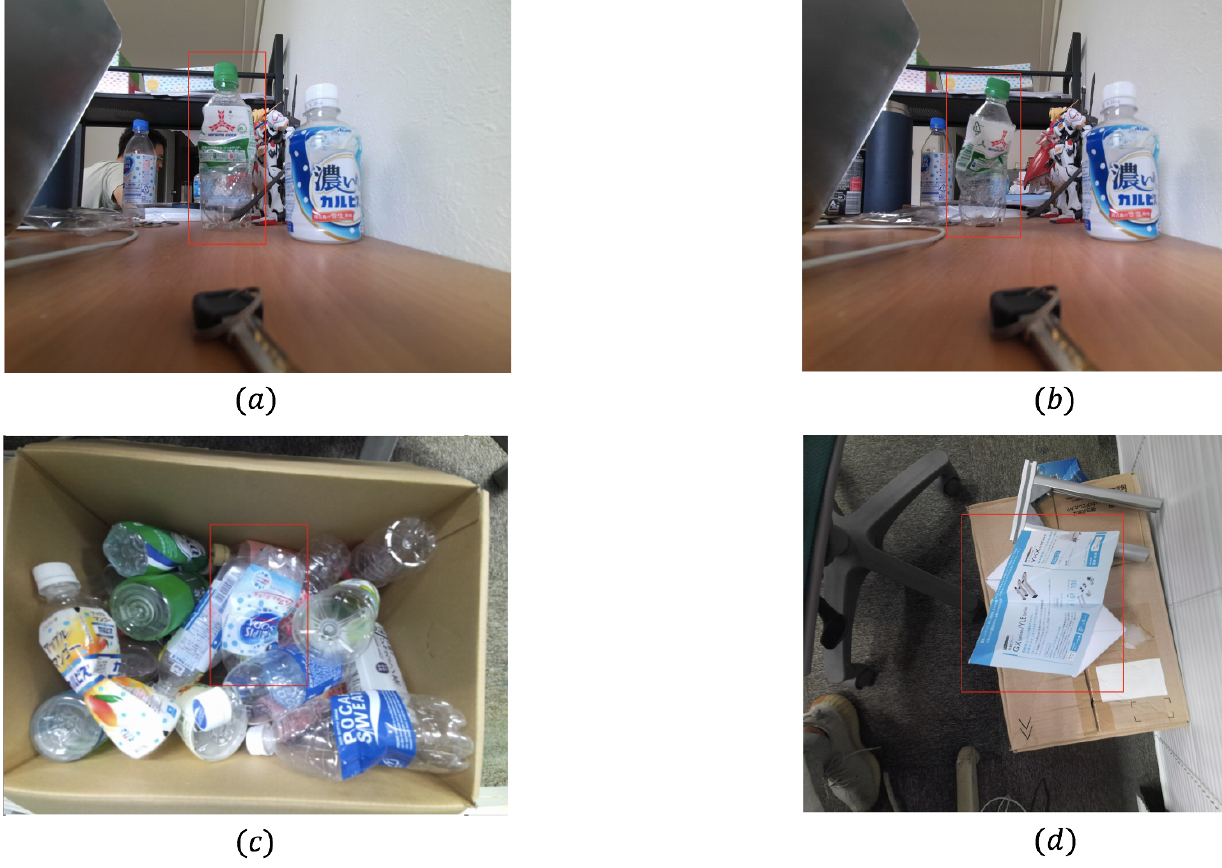
Figure 14. Four cases for clustering: ( a ) a bottle with low degree of deformation; ( b ) same bottle with case ( a ) but with a higher degree of deformation; ( c ) a deformed bottle in a box filled with different kinds of bottles; ( d ) a deformed paper with three bending